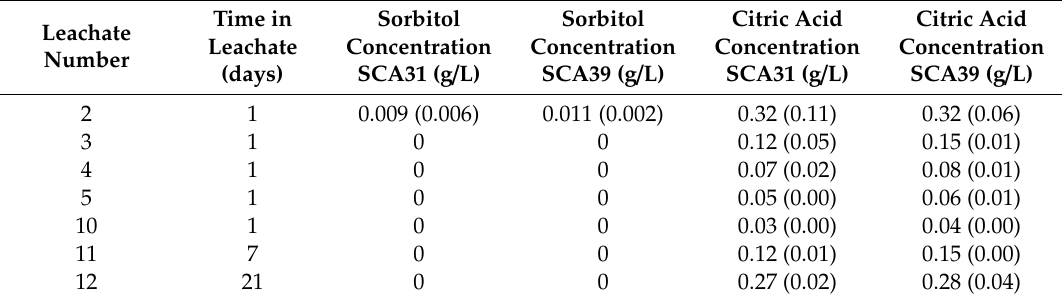
Table 2. Sorbitol and citric acid concentrations of leachates measured with HPLC. Standard deviation of four replicates in